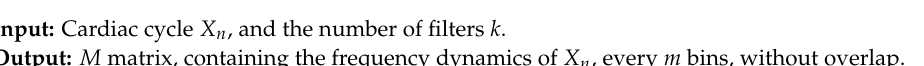
Algorithm A1 MFCC Algorithm